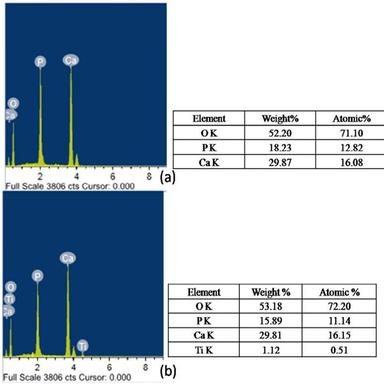
EDAX analysis of (a) pure HAp and (b) doped HAp powder.